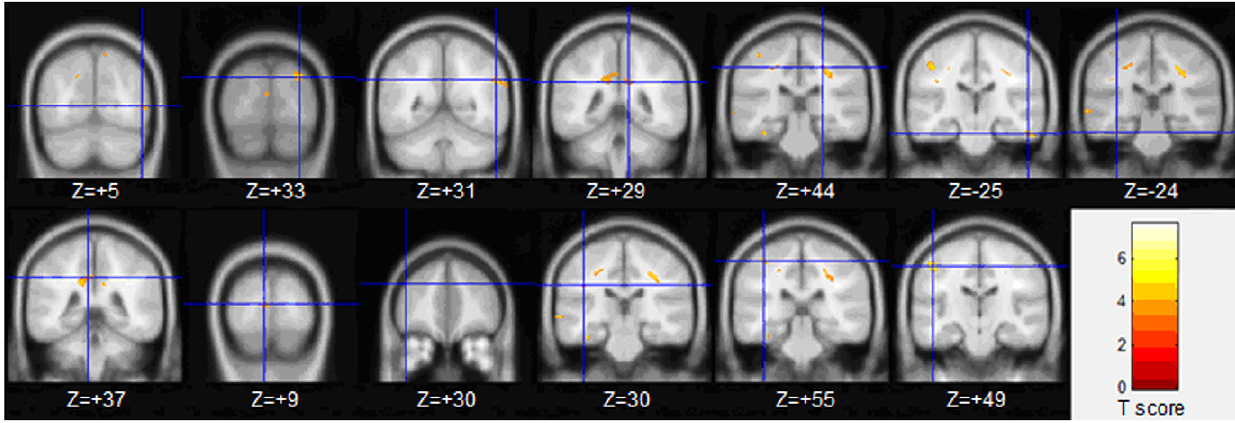
Figure 1. White matter regions with reduced volumes in adult strabismus. Strabismus patients showed smaller white matter in several regions, including the right middle occipital gyrus (Z= + 5), right occipital lobe/cuneus (Z= + 33), right supramarginal gyrus (Z= + 31), right cingulate gyrus (Z= + 29), right frontal lobe/sub-gyral (Z= + 44), right inferior temporal gyrus (Z= 2 25), left parahippocampa gyrus (Z= 2 24), left cingulate gyrus (Z= + 37), left occipital lobe/cuneus (Z= + 9), left middle frontal gyrus (Z= + 30), left inferior parietal lobule (Z=30), and left postcentral gyrus (Z= + 55, Z= + 49). doi:10.1371/journal.pone.0010931.g001 PLoS ONE |